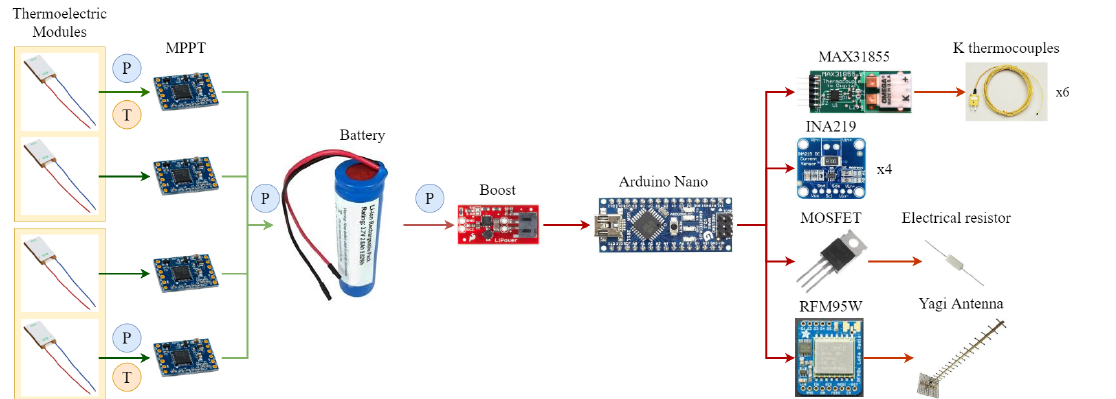
Figure 6. Diagram of the electronics installed with the prototype, which represents the node of the LoRa communication